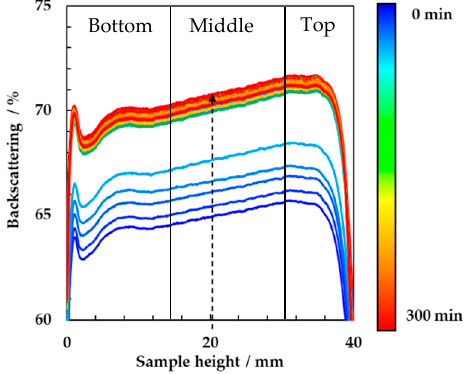
Figure 1. Backscattering spectra of milk sample incubated at 44 °C and inoculated with 4.5% ( w/w ) of yogurt starter culture for 1080 min.